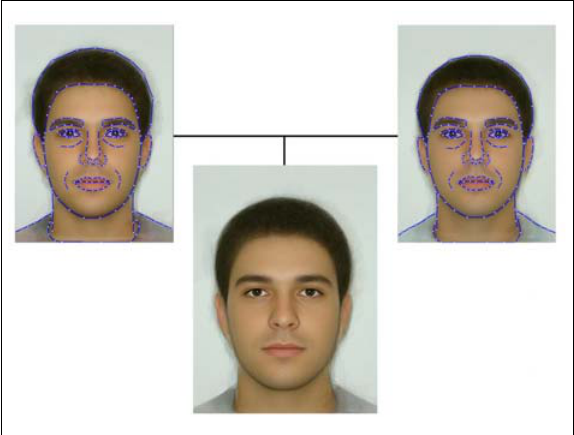
Figura 1 . Marcaram-se todos os pontos que definem os contor- nos das características de cada uma das faces. As imagens foram pareadas e interpoladas, duas a duas, gerando faces intermediá- rias cuja similaridade com as faces que a geraram foi de 50%. As faces intermediárias, duas a duas, foram interpoladas até se che- gar a uma única face, o